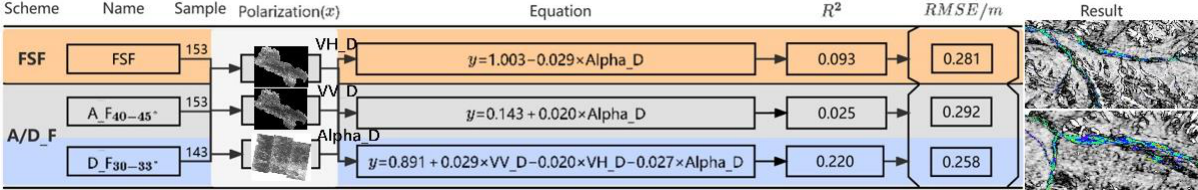
Figure 11. Stepwise regression fitting equations for the Binggou River. VH_D is the VH polarization of the descending orbit image, VV_D is the VV polarization of the descending orbit image, and Alpha_D is the descending orbit scattering angle. The orange and blue colors indicate the method with better accuracy for each scheme.